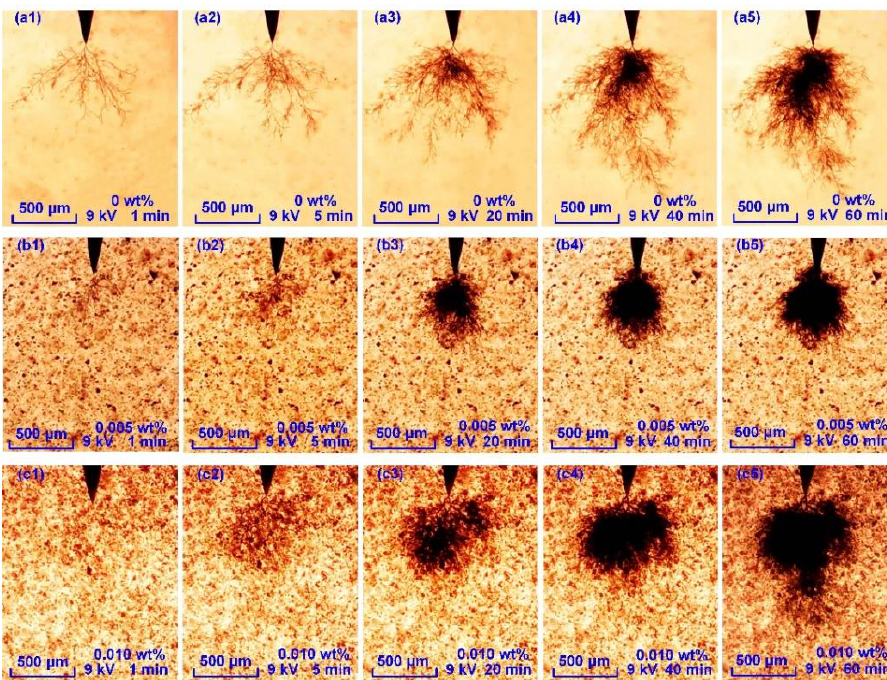
Figure 8. Tree growth process in graphene/silicone rubber (SIR) nanocomposites with different contents. ( a1 – a5 ) Tree growth in undoped SIR; ( b1 – b5 ) tree growth in nanocomposites with 0.005 wt % and ( c1 – c5 ) tree growth in nanocomposites with 0.010 wt %. Polymers 2019 , 11 , x FOR PEER REVIEW